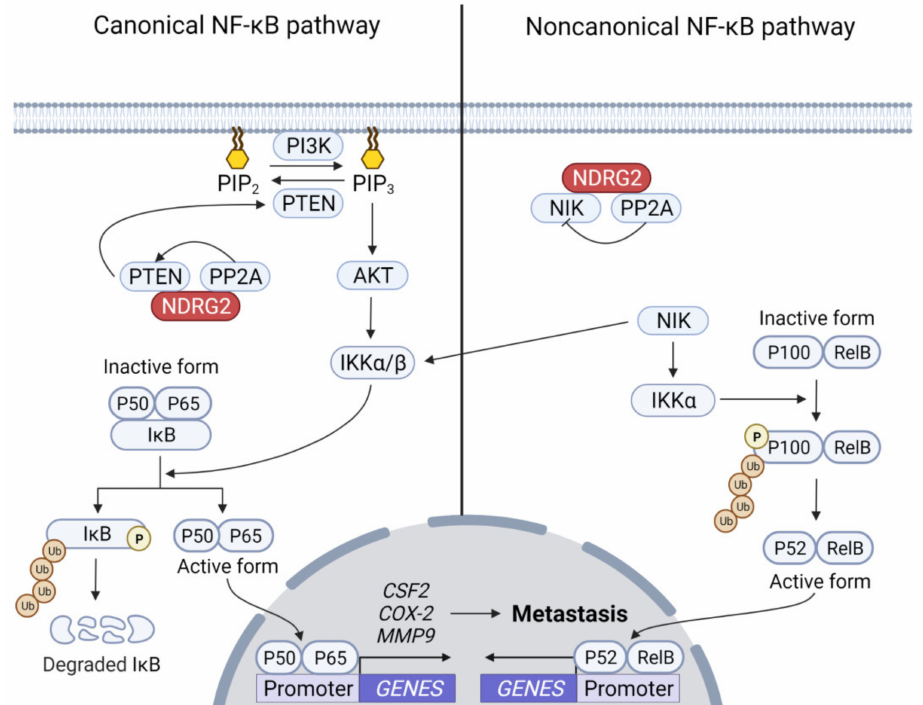
Figure 2. Inhibition of NF- κ B-dependent tumor cell metastasis by NDRG2. The PI3K/AKT/ IKK α /NF- κ B pathway contributes to tumor cell metastasis by inducing related genes, such as CSF2 , COX-2 , and MMP9 . IKK α is also a substrate of NIK. NDRG2 inhibits the canonical NF- κ B pathway via AKT inhibition to inhibit IKK α activation. Activated NIK induces phosphorylation of IKK α , which phosphorylates p100 to process p100 to p52 in a proteasome-dependent manner. The NDRG2–PP2A complex dephosphorylates NIK to inhibit the non-canonical NF- κ B